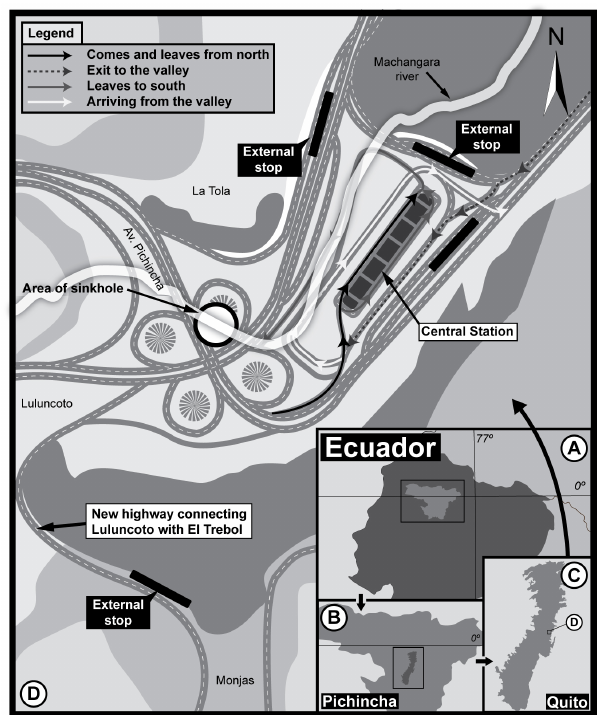
Figure 1. Overview of the setting of (a) Ecuador, (b) province of Pichincha, (c) city of Quito, and (d) El Trébol and surrounding in- frastructure.